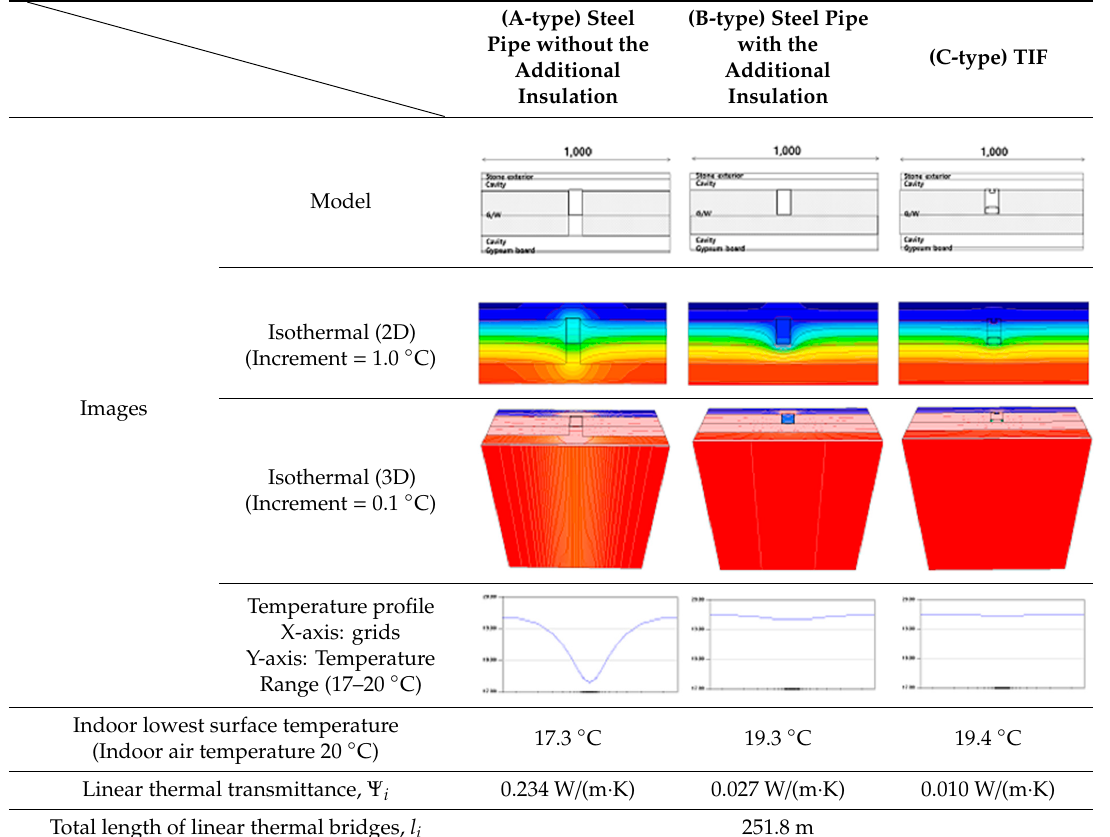
Table 7. Calculated linear thermal transmittance values.